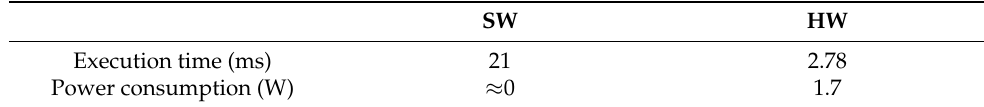
Table 1. Comparison of different HW/SW Keccak implementation.